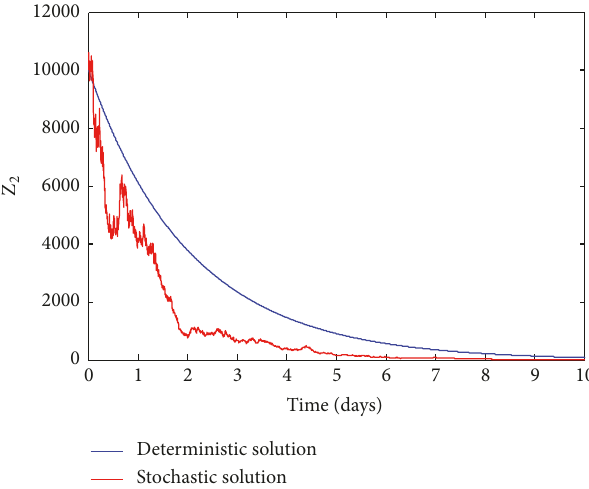
Figure 2: The approximate stationary solutions of 𝑍 2 obtained for equations (1) and (5) with 𝜎 1 = 0.5 and 𝜎 2 = 0.5 .